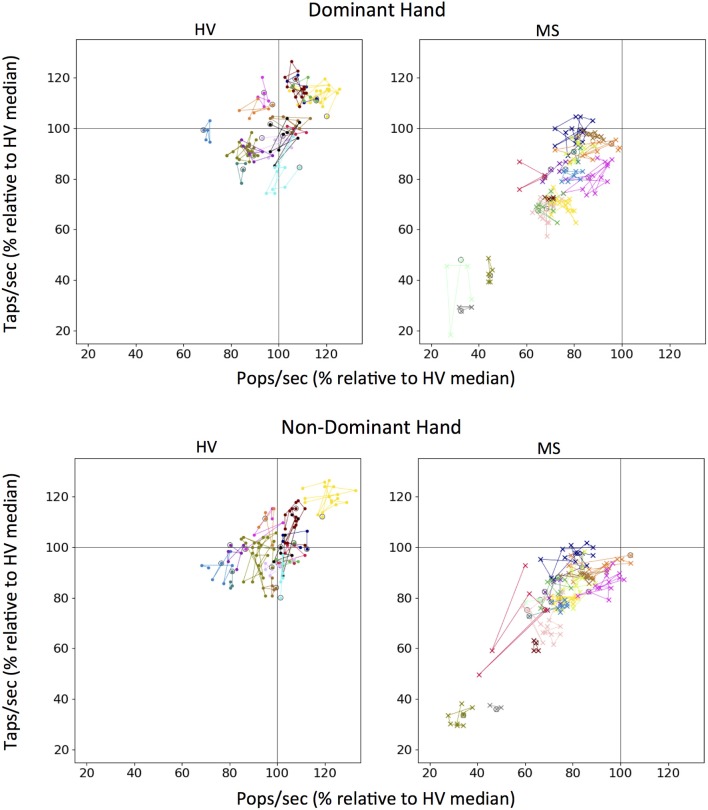
Longitudinal tapping test and balloon popping test data. Each color on a graph represents an individual testing participant and first test sitting is circled in black. Colors for unique individuals are consistent between dominant and non-dominant hand plots. One hundred percent mark (gray lines) for both scores was derived from the median of all Healthy Volunteer (HV) longitudinal data for tapping and popping respectively.